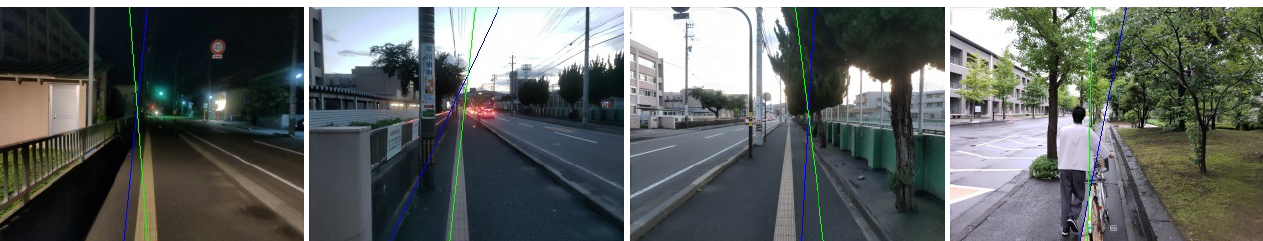
Figure 8. Success ratio plot with respect to the whole ( a ) and partial ( b ) dataset.